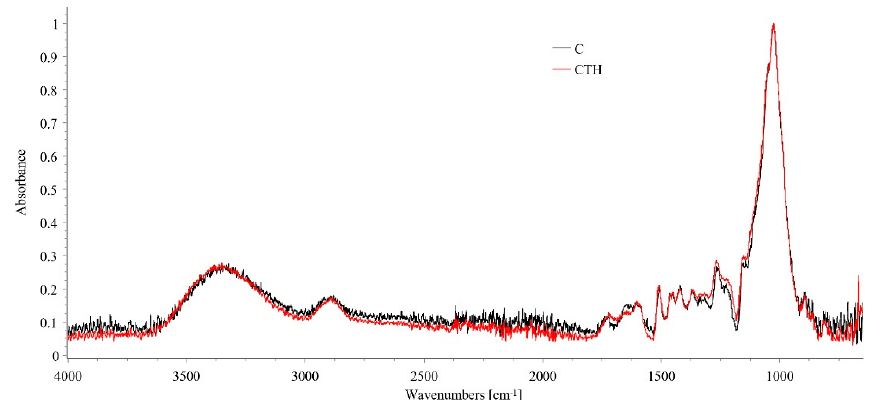
Figure 4. Comparison of FTIR spectra of cedar wood samples before and after the thermal modification (C and CTH).